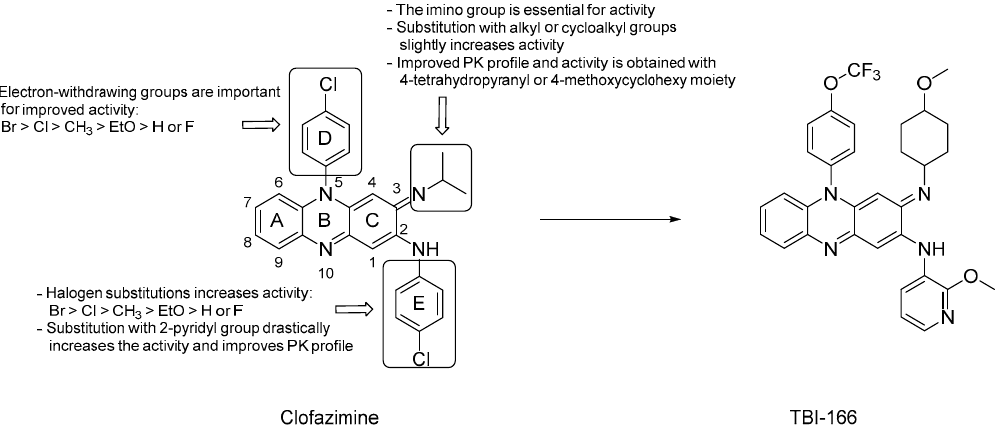
Figure 2. SARs of riminophenazines and chemical structures of clofazimine and